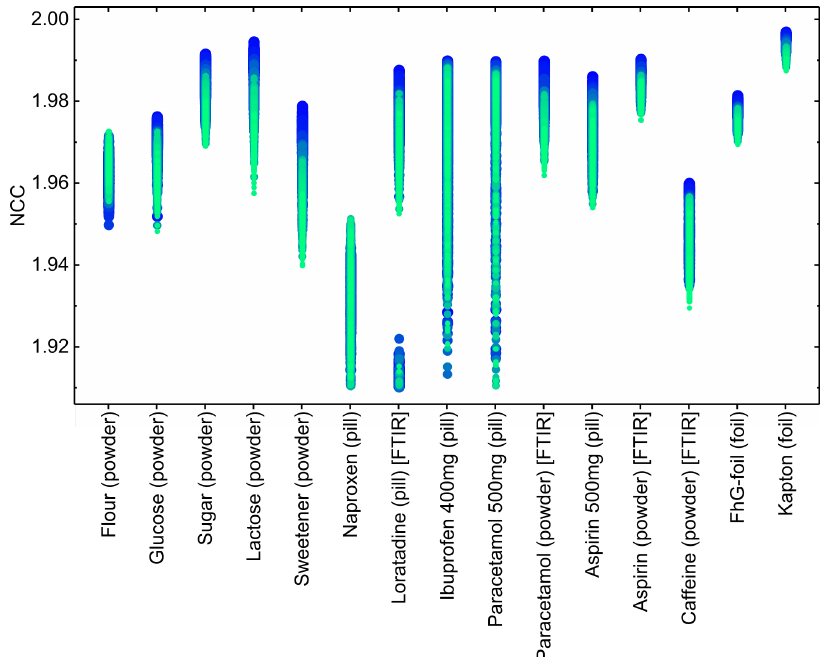
Figure 7. Investigation of the long-term stability of the demonstrator system using the T2SL detector. The time information is encoded in color and size of the dots, i.e., early results are represented by big blue dots, whereas later results are given by smaller and greener dots. Please note the two groups for loratadine, where the lower ones correspond to false